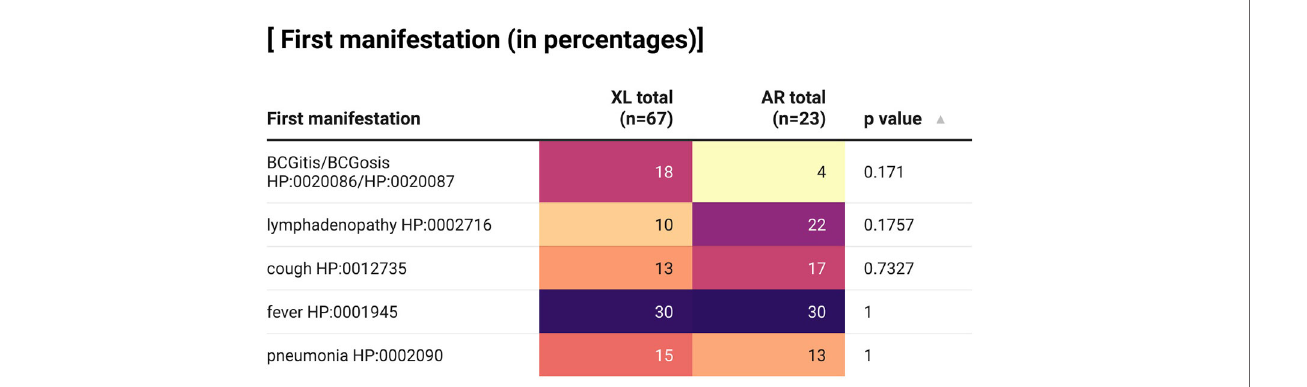
FIGURE 2 | A heat map describingpercentages ofCGD patients inour case series with certain fi rst manifestationsaccordingto their clinicalrecords. XL, X-linked; AR, autosomal recessive; BCG, BacillusCalmette – Gue ́ rin.Fisher ’ s exact test isused, p -value <0.05 issigni fi cant. This graphiscreatedby usingthe app Datawrapper.